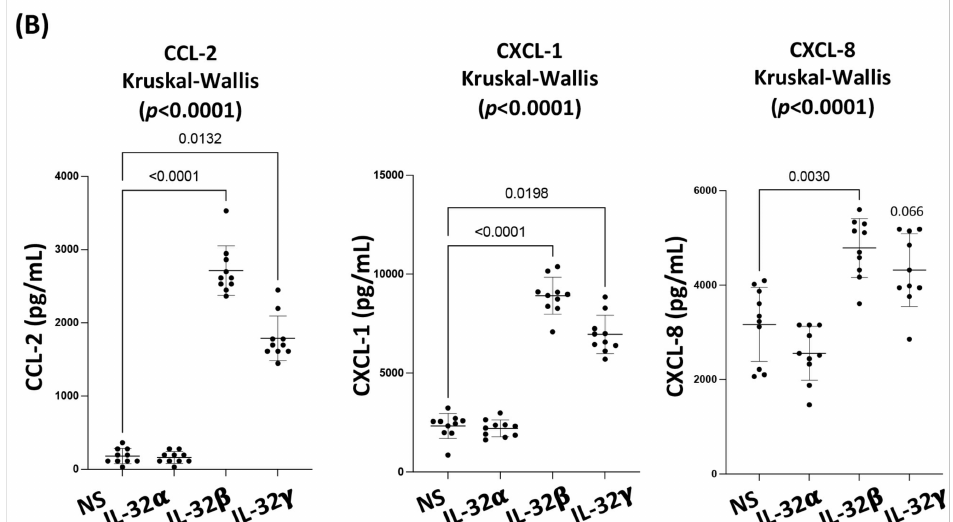
Figure 3. IL-32 β and γ increase chemokine production in coronary artery endothelial cells. ( A ) Analysis of CCL-2, CXCL-1 and CXCL-8 RNA expression, normalized to the housekeeping gene β -glucuronidase, in CAEC following 12 h stimulation with IL-32 α , β and γ (500 ng/mL, n = 10). ( B ) Analysis for the production of CCL-2, CXCL-1 and CXCL-8 proteins in CAEC supernatants follow- ing stimulation with IL-32 α , β and γ for 72 h (500 ng/mL, n = 10 experimental replicates from CAEC). Data analyzed with the non-parametric test Kruskal-Wallis and Dunn’s subtest. NS: